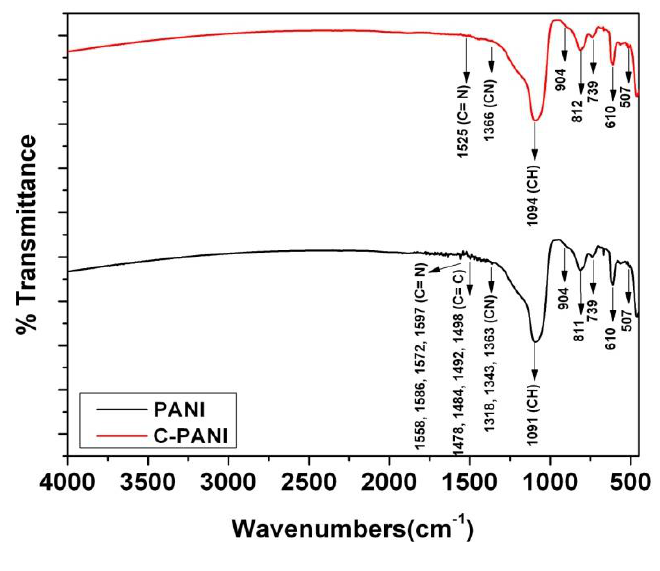
Figure 4. FTIR analysis of PANI and C-PANI